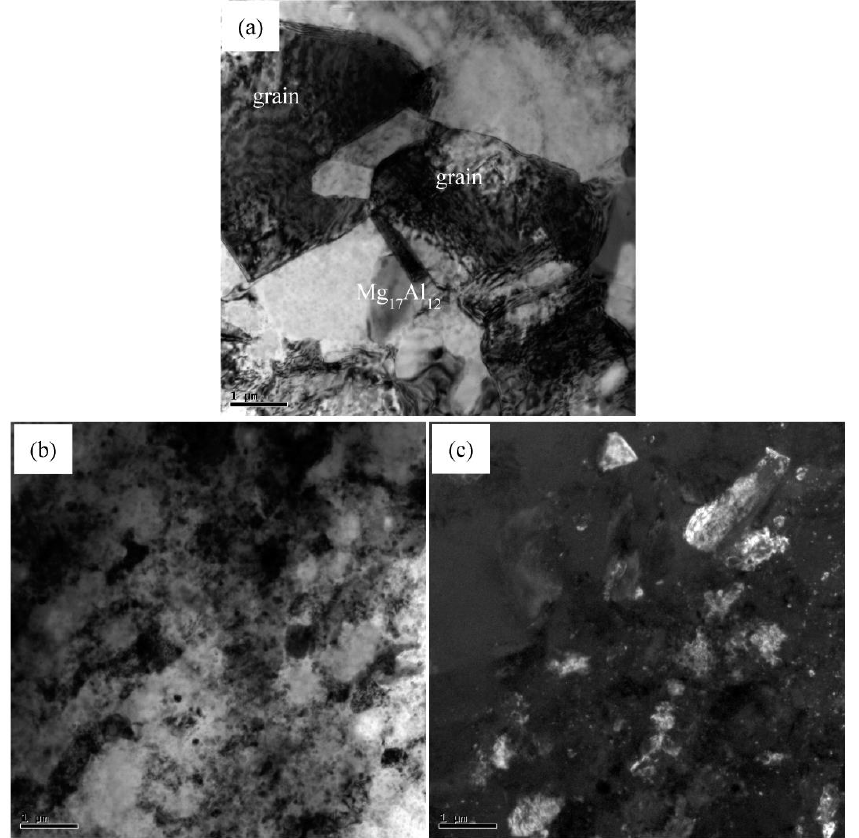
Figure 10. TEM micrographs of nano-SiCp/AZ91 composite after 6 passes at 400 °C and 3 passes at 350 °C: ( a ) DRX grains and precipitated phase; ( b ) bright field image and ( c ) dark field image of distribution of SiC nanoparticles.